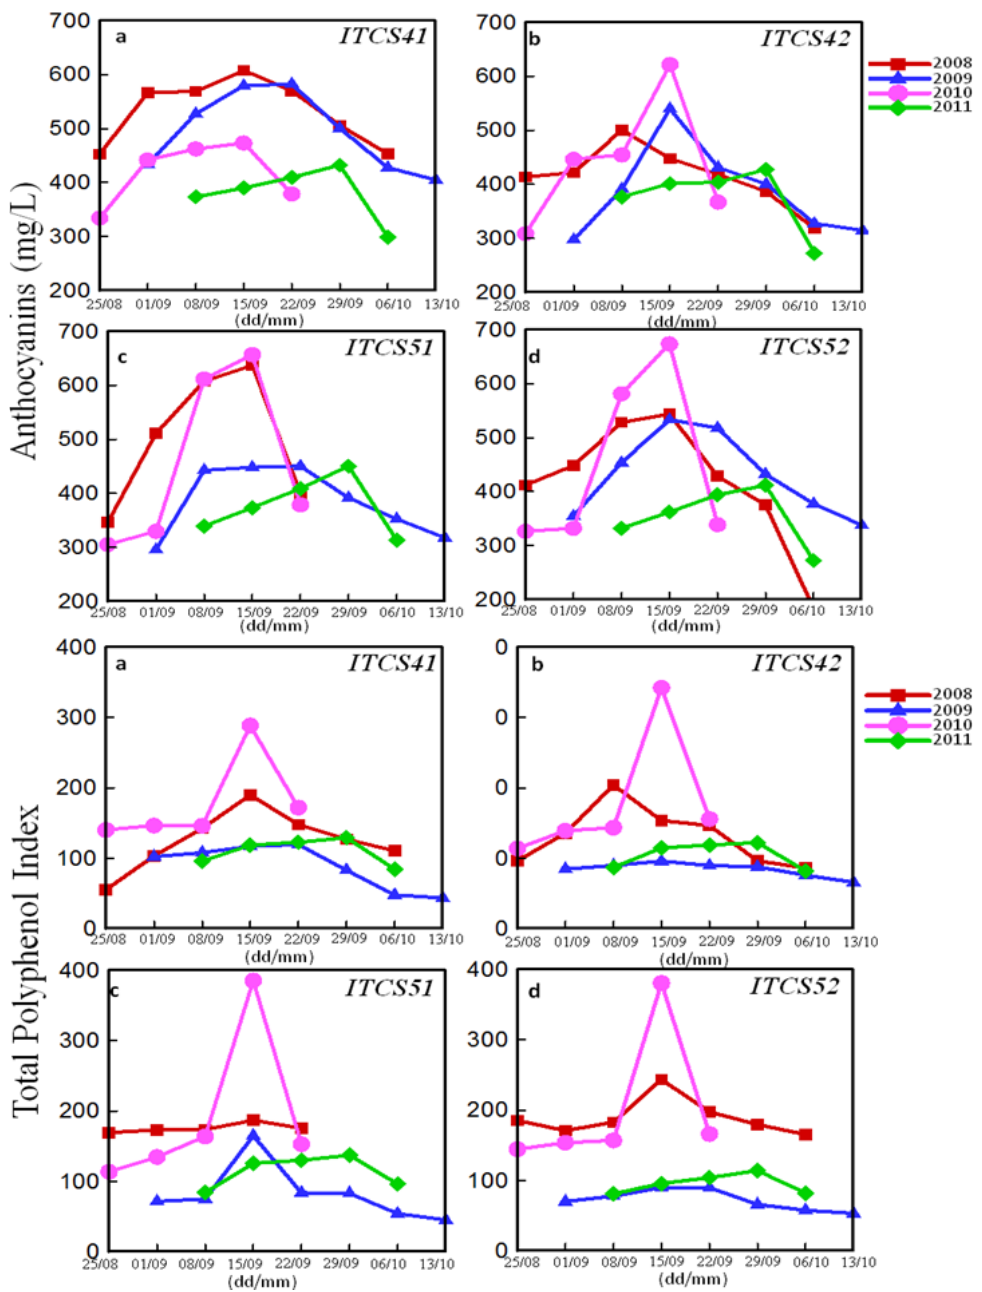
Figure 1. Anthocyanin content (mg/L) and total polyphenol index (IPT) (calculated by Institut Technique de la Vigne et du Vin (ITV) method) of four plots ITCS41 ( a ); ITCS42 ( b ); ITCS51 ( c ); and ITCS52 ( d ) of Cabernet Sauvignon grapes as a function of time (day (dd)/month (mm)) over four years (2008, 2009, 2010, and 2011).